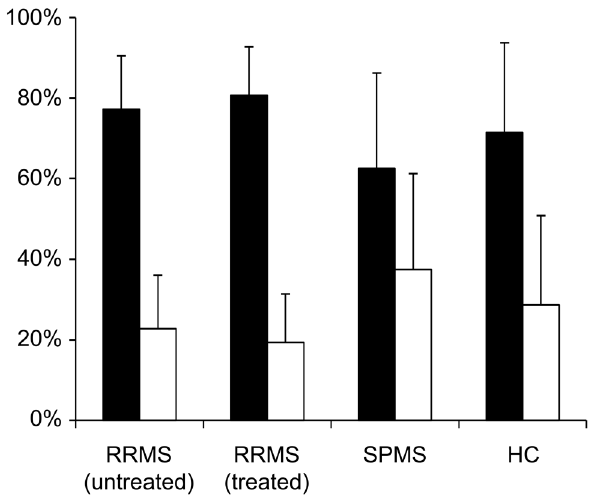
Figure 1. Flow cytometry indicates similarity in proportions of cells with a naı¨ve B cell or memory B cell marker phenotype among LCLs from healthy donors and patients with MS. LCLs were typed for memory and naı¨ve B cell cell-surface phenotype by flow cytometry, by CD19 and CD27 immunoreactivity. The percentage of cells for each subset is shown for LCLs from donors with relapsing remitting MS that did not receive any therapy prior to the time of phlebotomy (RRMS: untreated, n=12), donors with relapsing remitting MS under IFN- b therapy (RRMS: treated, n=12), donors with secondary progressive MS (SPMS, n=9), and donors that were healthy controls (HC, n=5). Black bars: CD19 + CD27- naı¨ve B cells; white bars: CD19 + CD27 + memory B cells. No differences were observed between all comparison groups (Mann Whitney test).